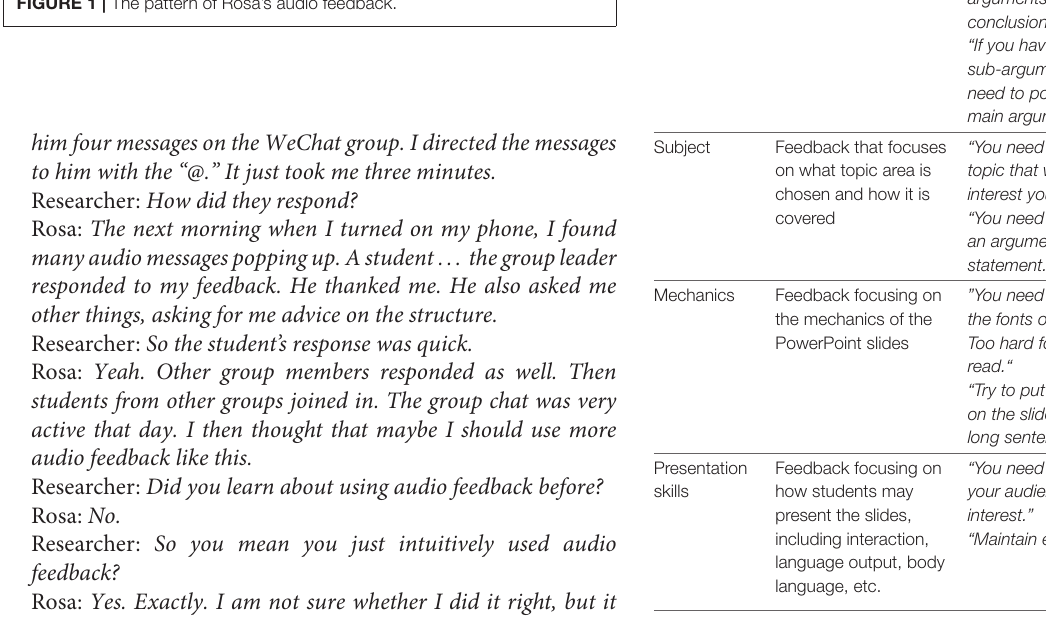
FIGURE 1 | The pattern of Rosa’s audio